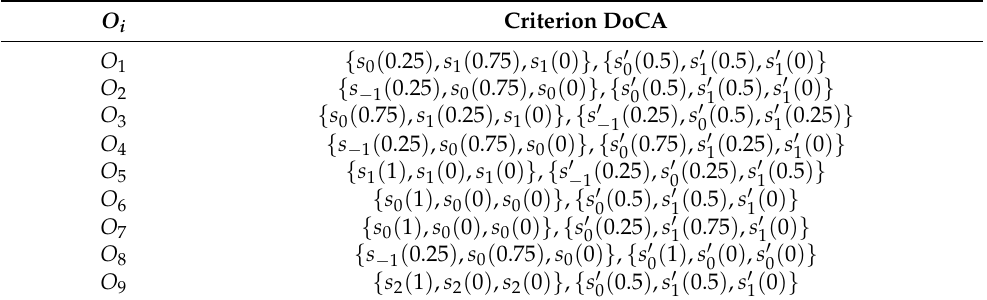
Table 14. Normalized qualitative matrix for criterion DoCA.